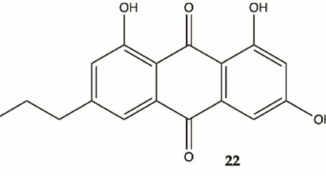
Figure 10. Antraquinone 22 isolated from the marine Echinoderm Comanthus sp [49].